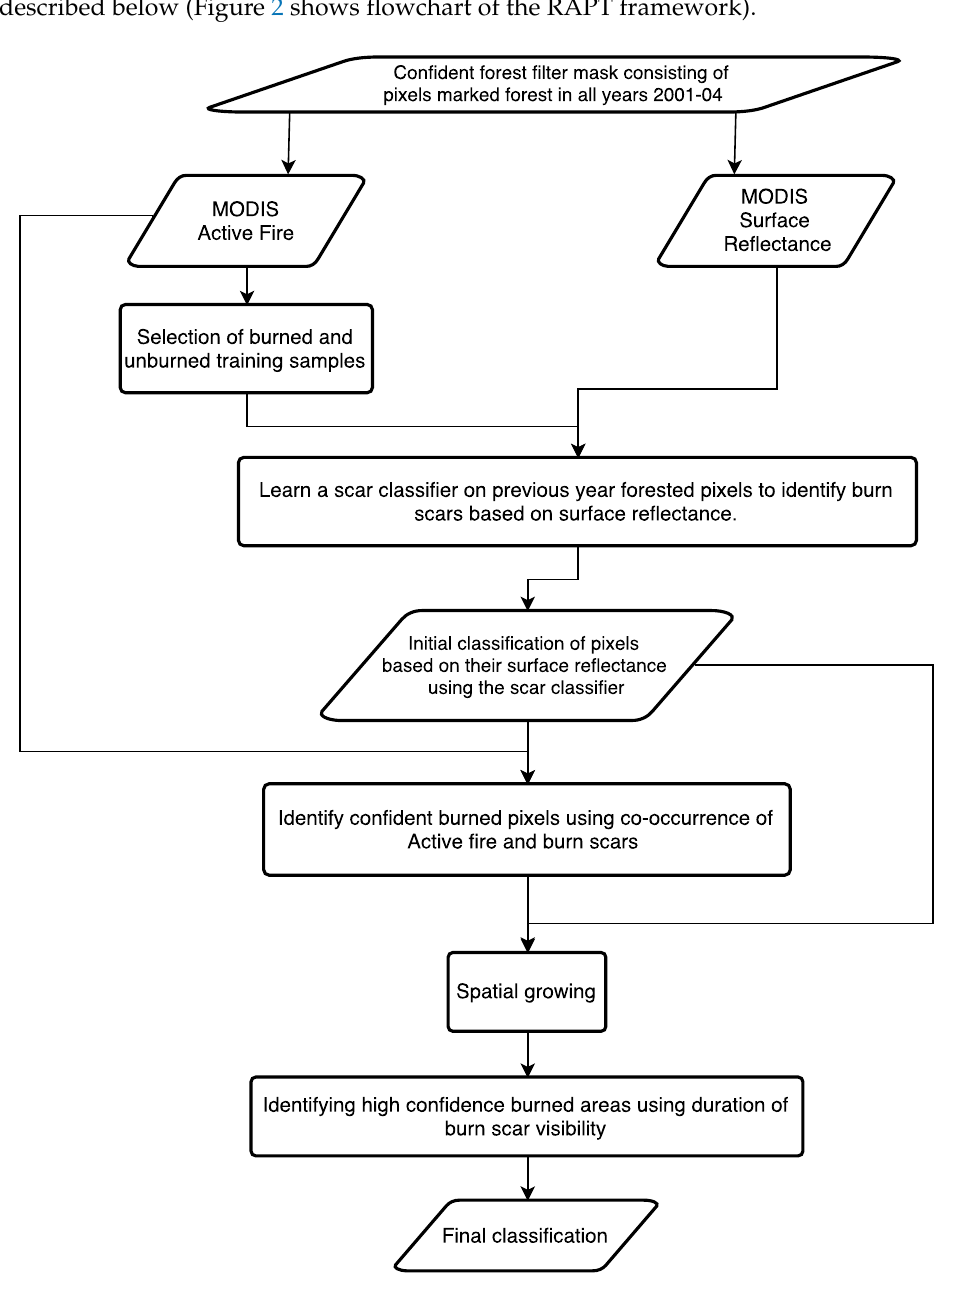
Figure 2. Flowchart showing the steps of the RAPT